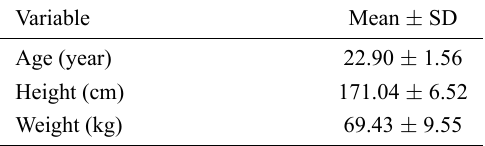
Table 1. General subject characteristics (n =